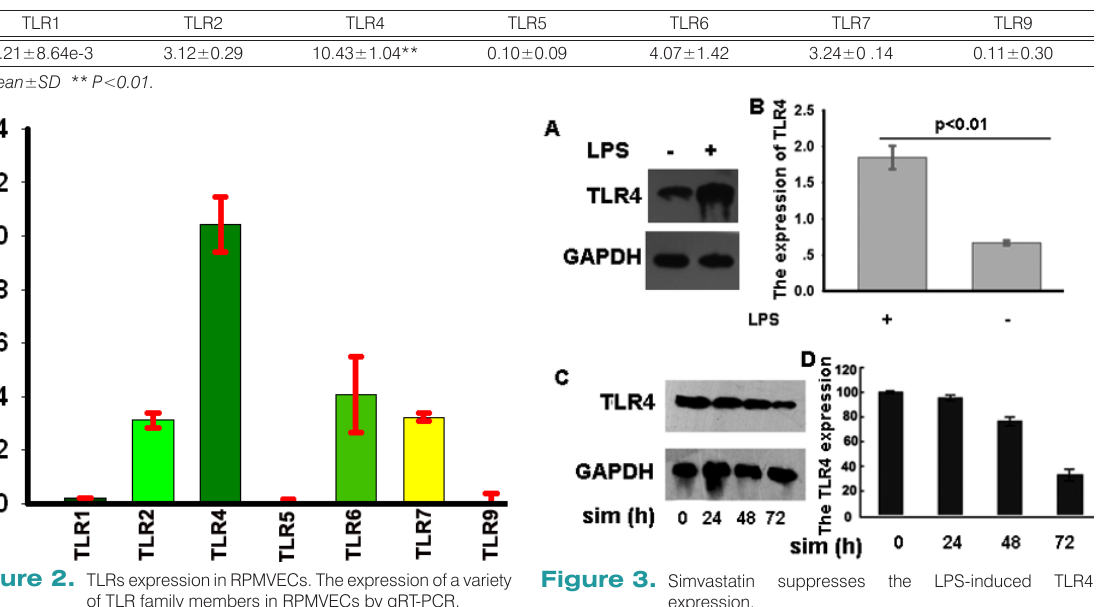
Table 2. The mRNA expression of TLRs in the rat pulmonary microvascular endothelial